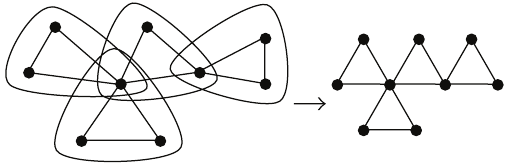
Figure 1: A 3-uniform linear hypertree 𝐻 and its completely connected graph 𝐺 𝐻 .